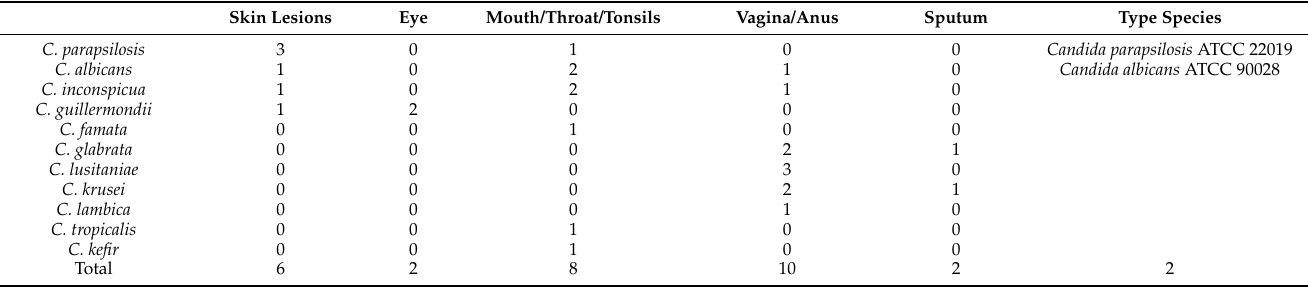
Table 6. Characteristics of the pathogenic Candida yeast strains used in the analysis. Skin